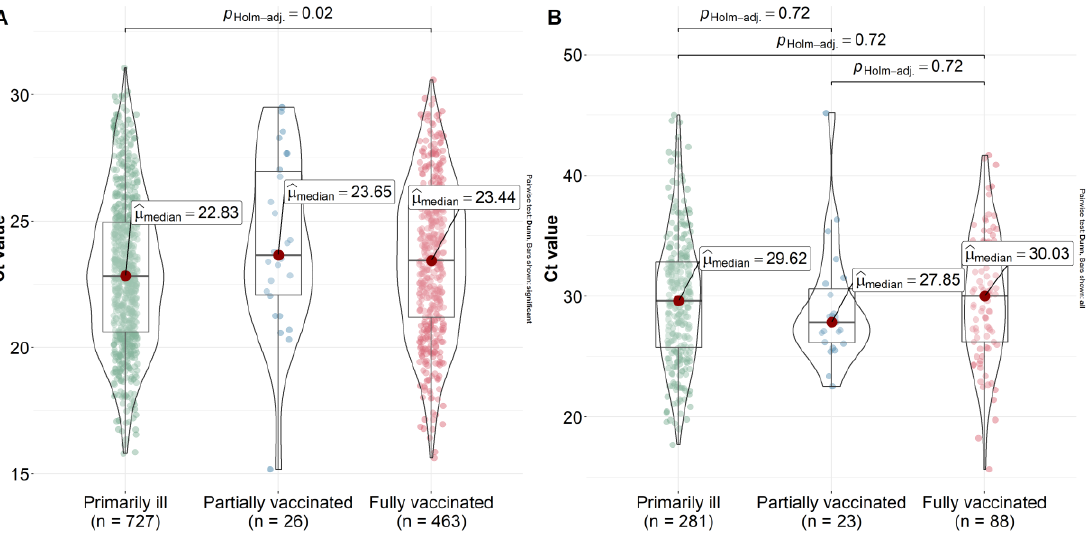
Figure 6. Ct value in primary detected, partially, and fully vaccinated patients in ( A ) the period that the Delta variant dominated and ( B ) the period that the Omicron variant dominated. The ordinate scale is represented by the Ct